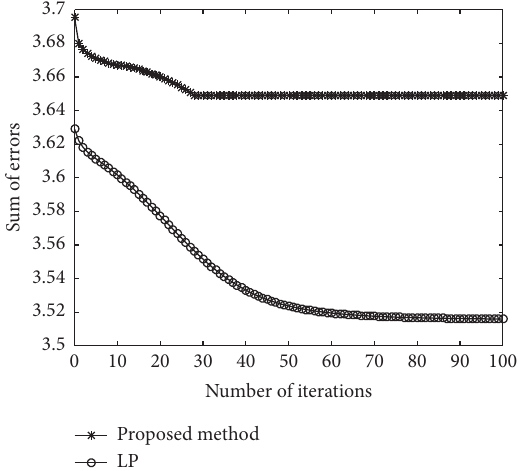
Figure 8: L ( i ) versus the number of iterations.